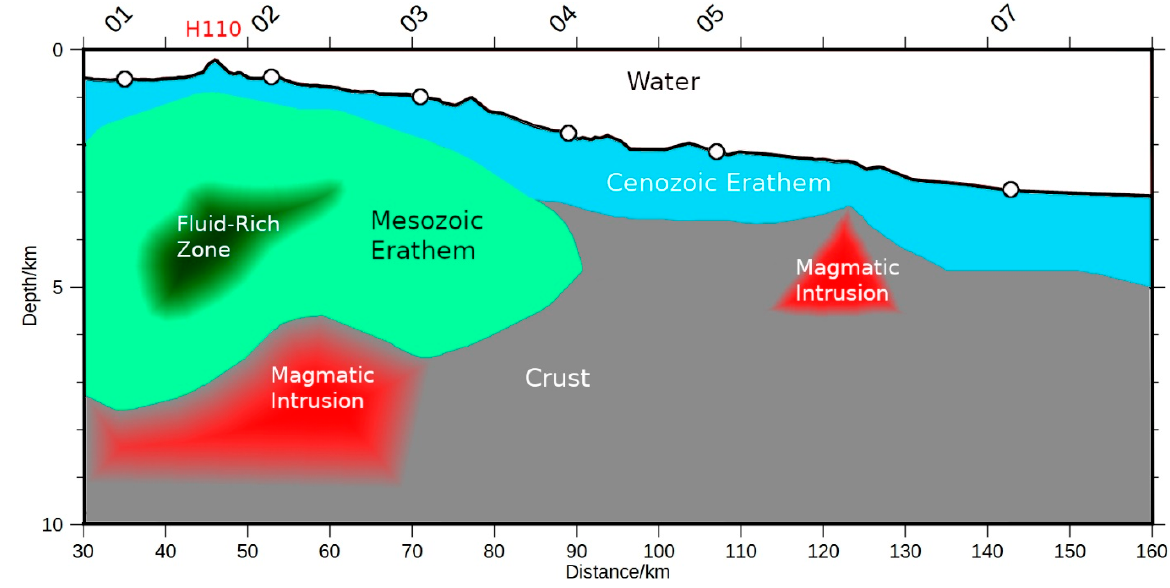
Figure 12. The geological interpretation alone Line L2016-2.